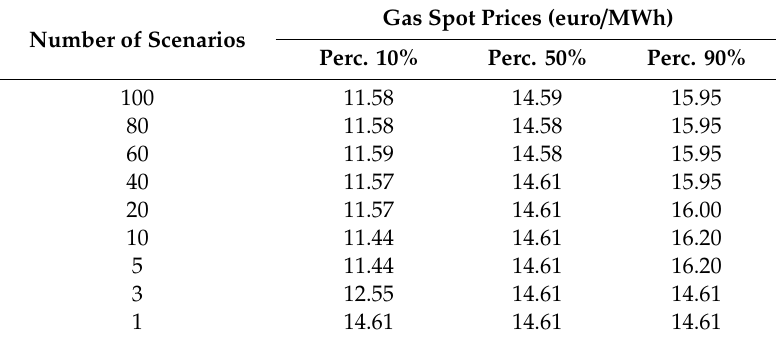
Table 9. Average 10, 50, and 90 percentiles of the probability distribution of gas spot price for di ff erent reduced sets of scenarios.